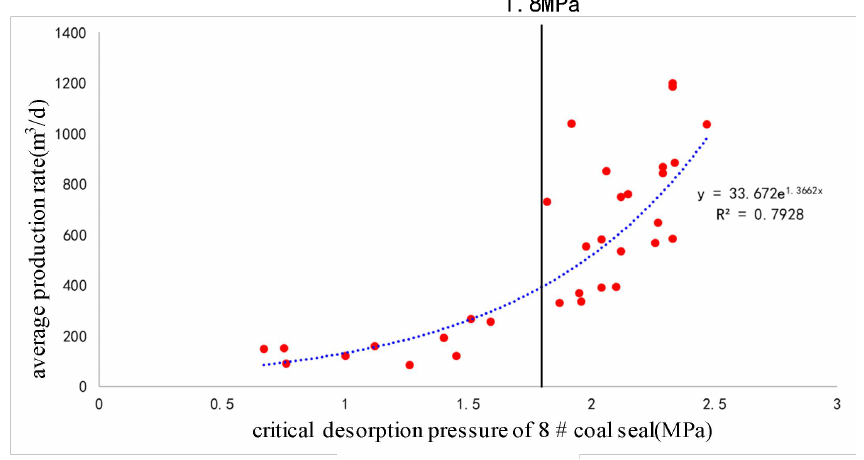
Figure1—The relationship between the gas critical desorption and average gas production